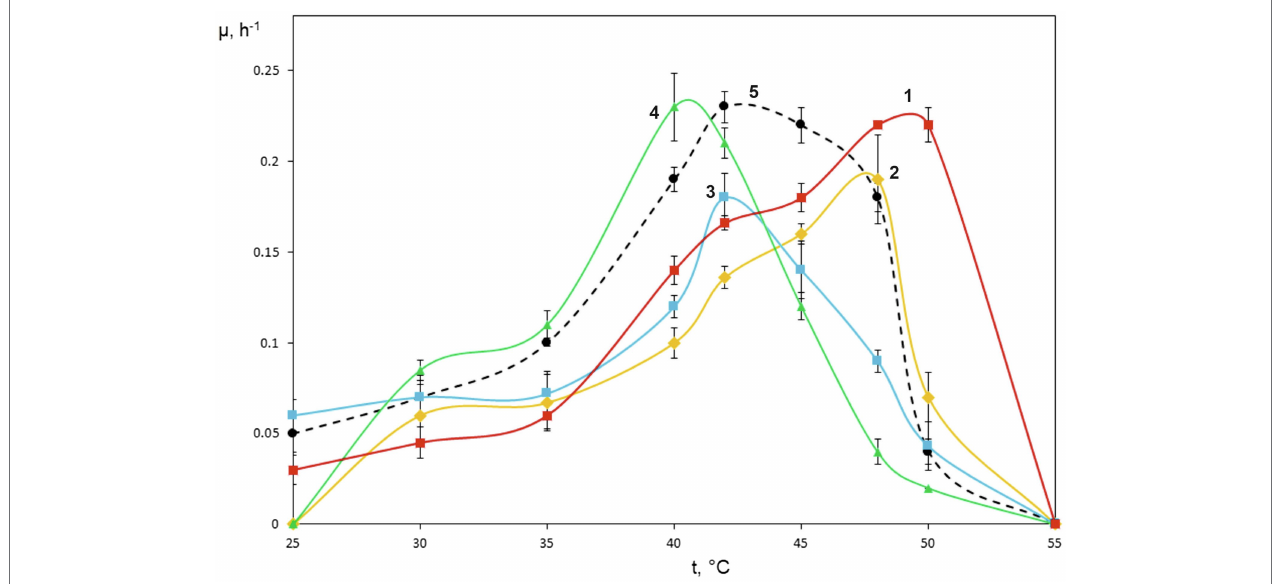
FIGURE 2 | Specific growth rates of novel isolates on methane as dependent on incubation temperature. Methylococcus capsulatus Bath was used as a reference organism. 1, strain KN2, 2, strain IO1, 3, BH, 4, Mc7, and 5, Methylococcus capsulatus